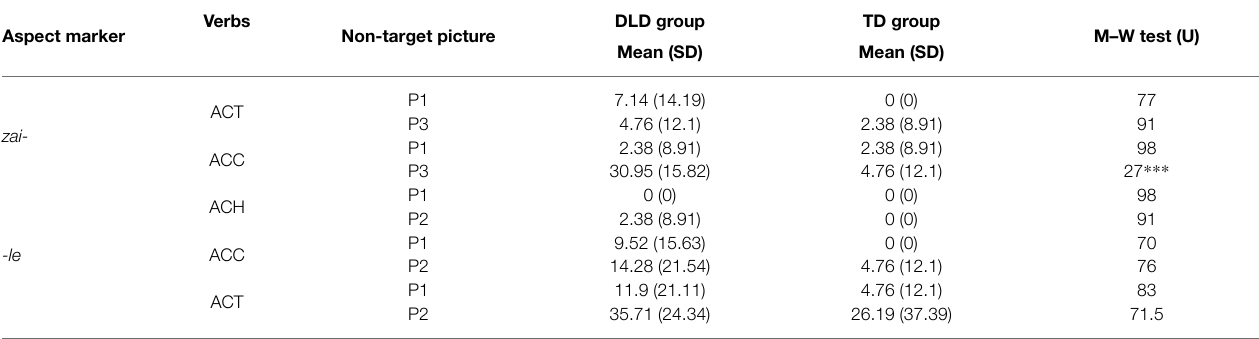
TABLE 5 | Proportions (%) of non-target pictures for aspect markers zai- and -le. Verbs Aspect marker Non-target